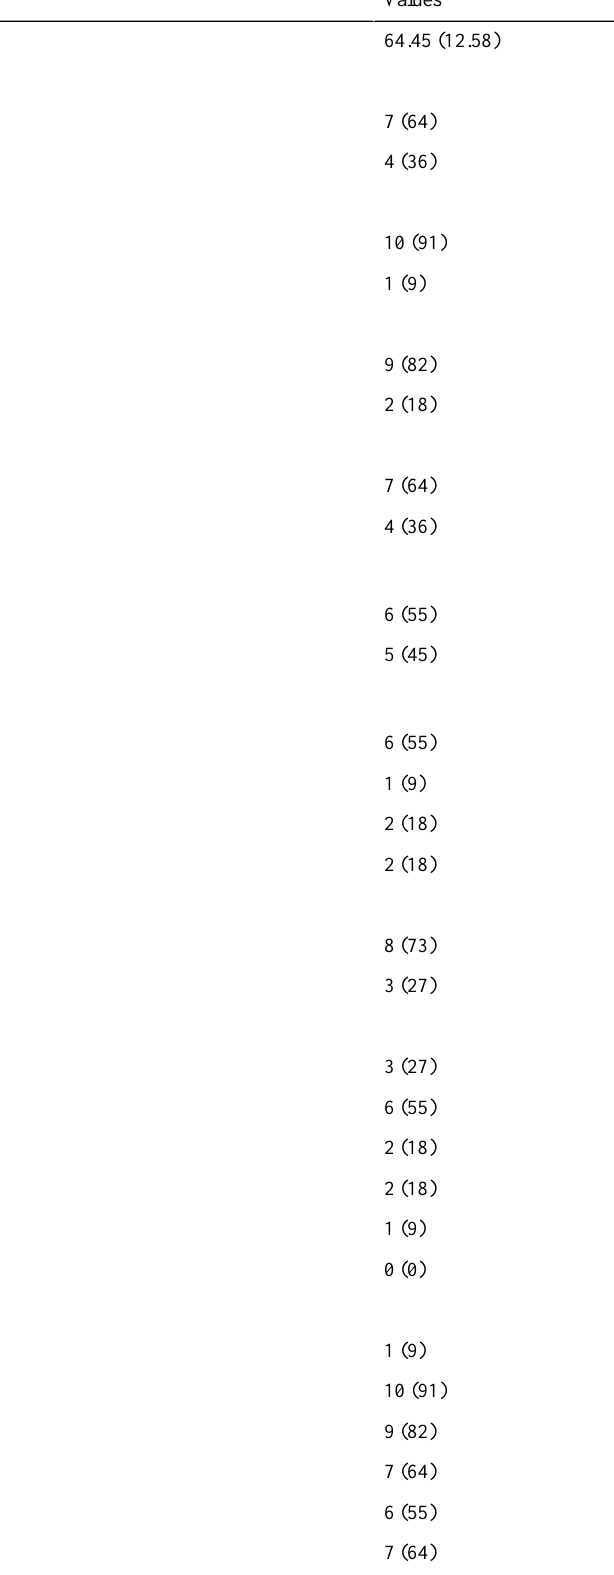
Table 1. Sociodemographic data and clinical characteristics of the participants